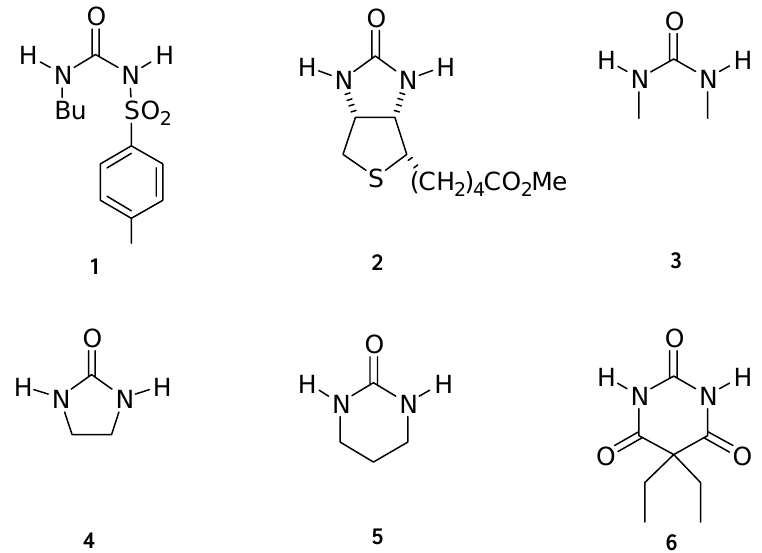
Figure 1. Structure of tolbutamide ( 1 ) and related guests.